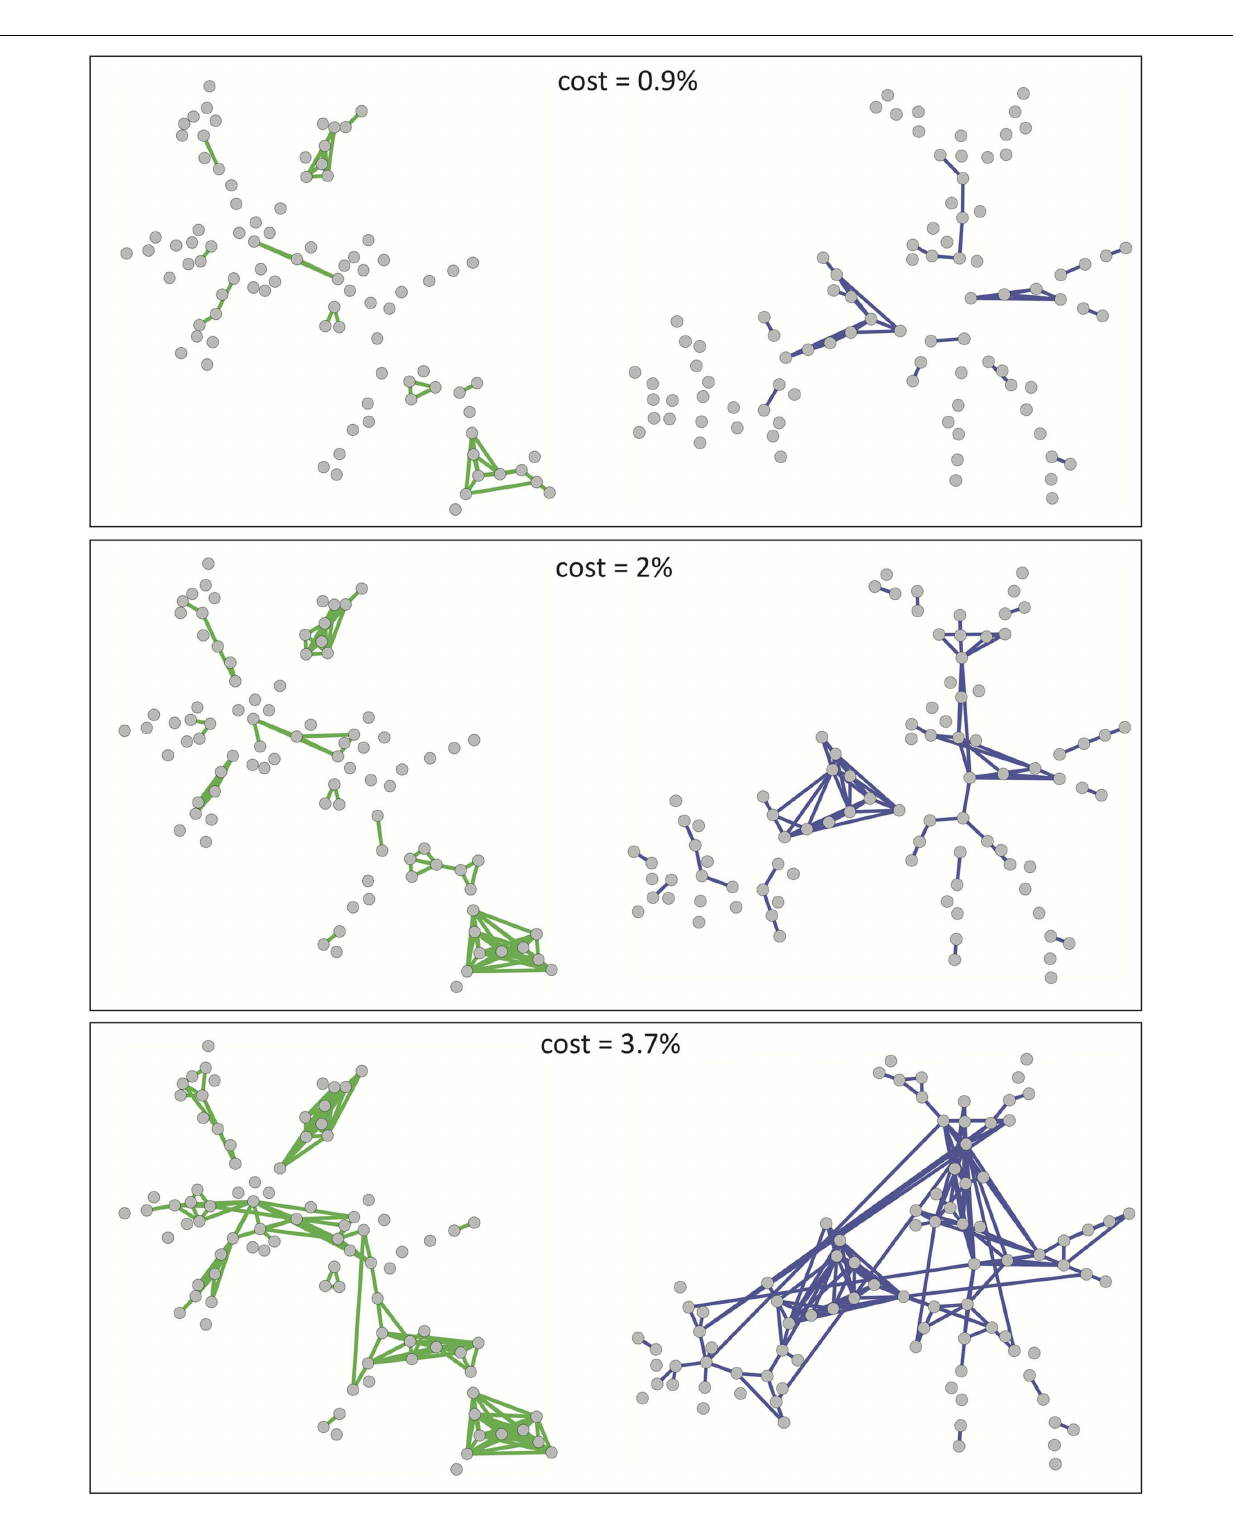
and brain functional networks in blue (right-hand column).Top, middle, and bottom rows of plots correspond to cost κ = 0.9, 2,